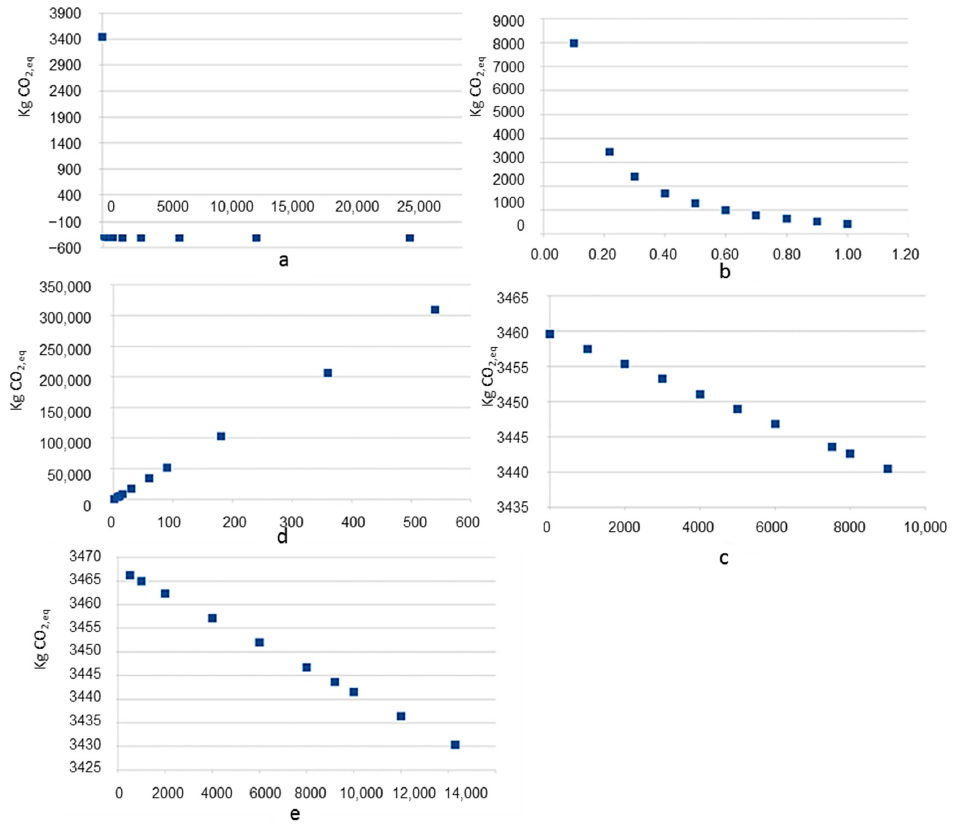
Figure 6. Representation of sensitivity analysis results for each parameter of the Climate Change impact category tons of platform removed ( a ); platform steel content in percentage by mass ( b ); average vessel days of effective operation ( c ); primary steel iron ore supply distance ( d ); primary steel coal supply distance ( e